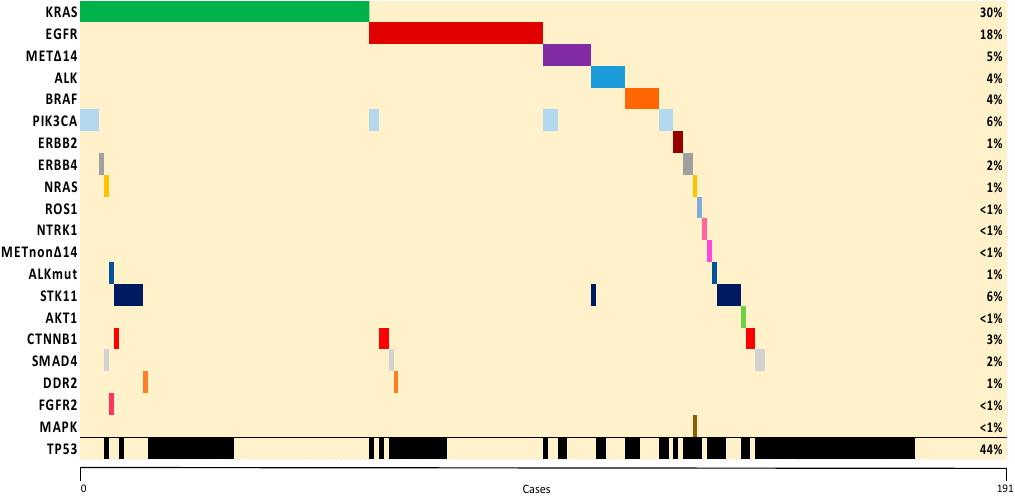
Figure 3. Co-mutation plot of genetic alterations identified. The percentage of samples with an alteration detected is noted on the right. Samples are displayed as columns and arranged to emphasize mutual exclusivity among mutations.